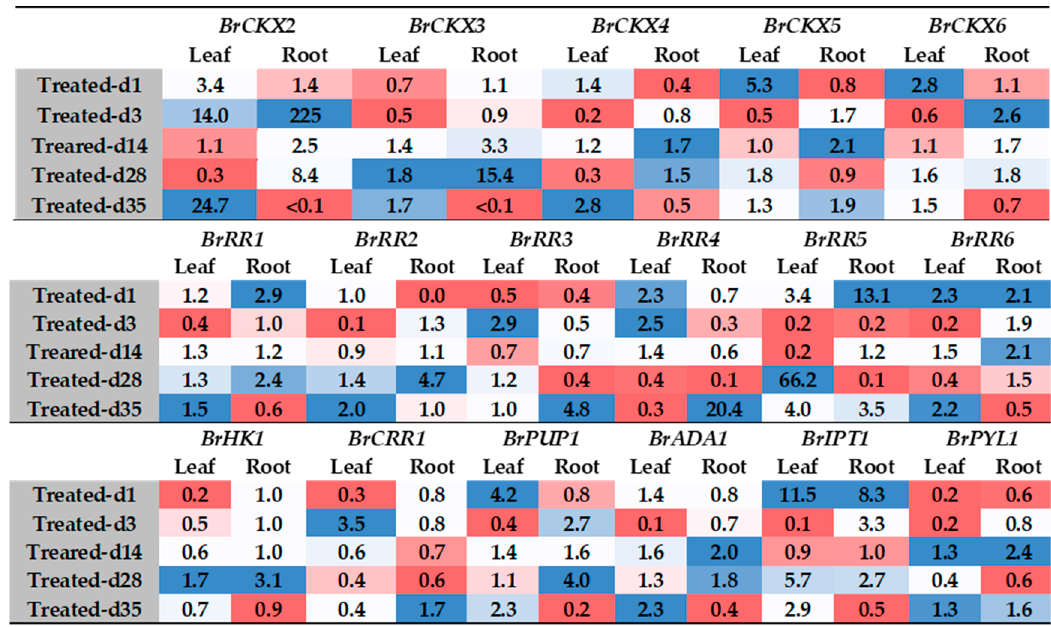
Figure 5. Fold changes in relative expression levels of cytokinin-related genes in Seosan-inoculated plants compared to mock-treated leaf samples at the same time-point. Blue and red colors represent upregulation and downregulation of genes, respectively. BrCRR1 is involved in protein phosphorylation and BrPYL1 is a receptor of ABA .